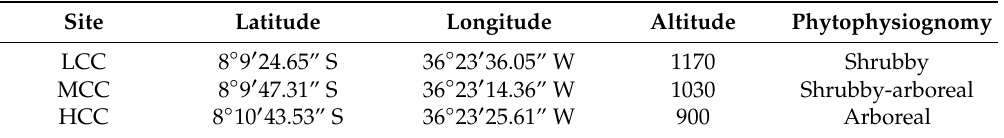
Figure 5. Collection sites with a clay gradient ( a ) LCC, ( b ) MCC, and ( c ) HCC. Table 5. Geographical coordinates, altitude and predominant phytophysiognomy in three areas with a clay gradient (LCC: Low Clay Content, MCC: Medium Clay Content, HCC: High Clay